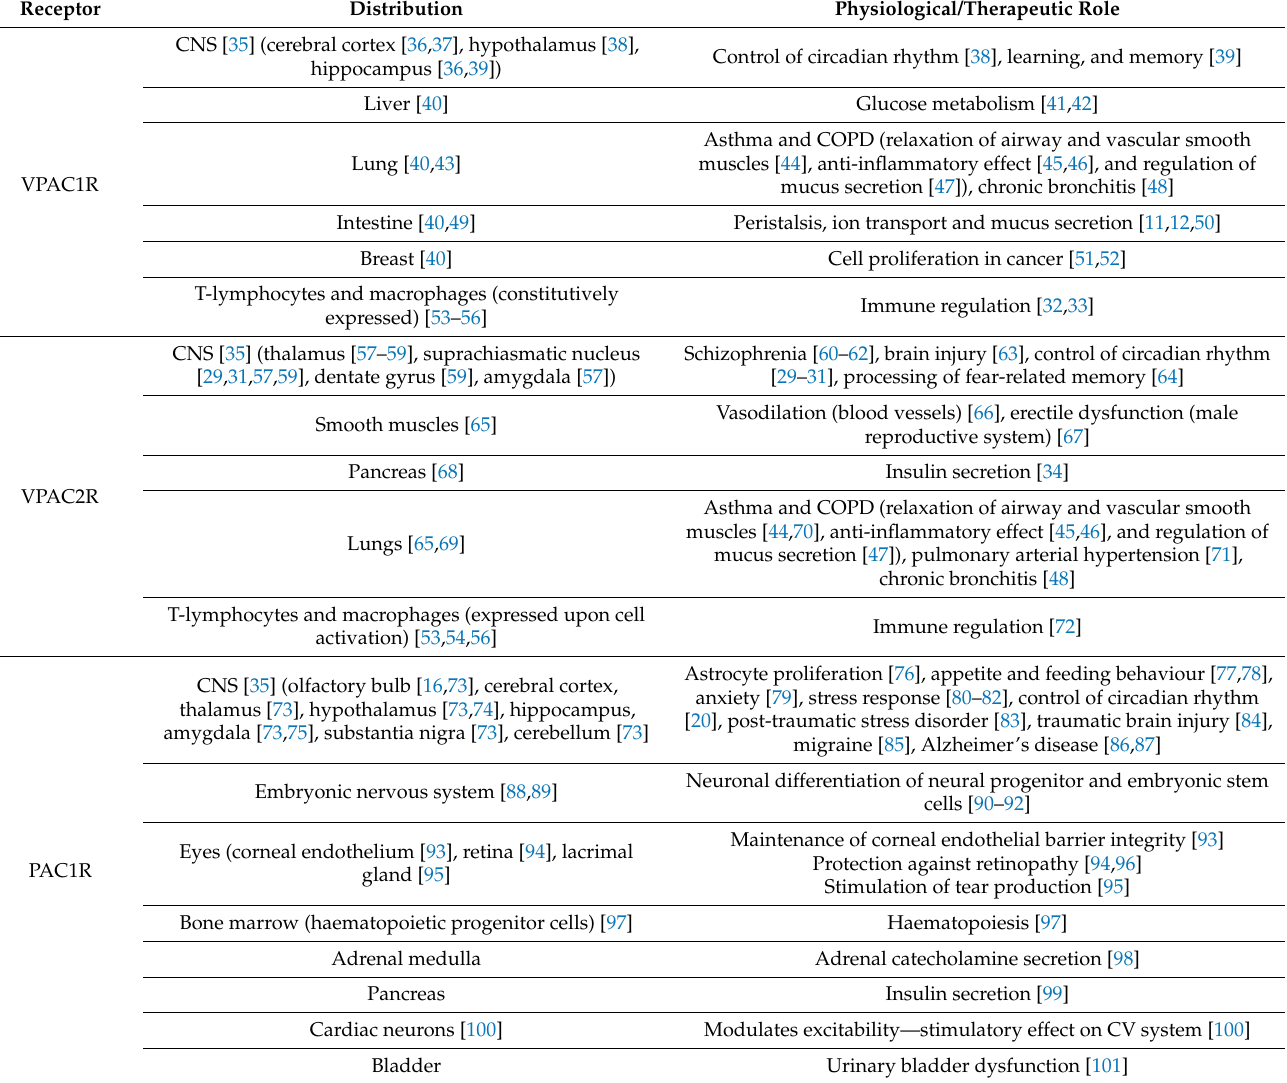
Table 1. Distribution and physiological or therapeutic role of the PACAP subfamily of